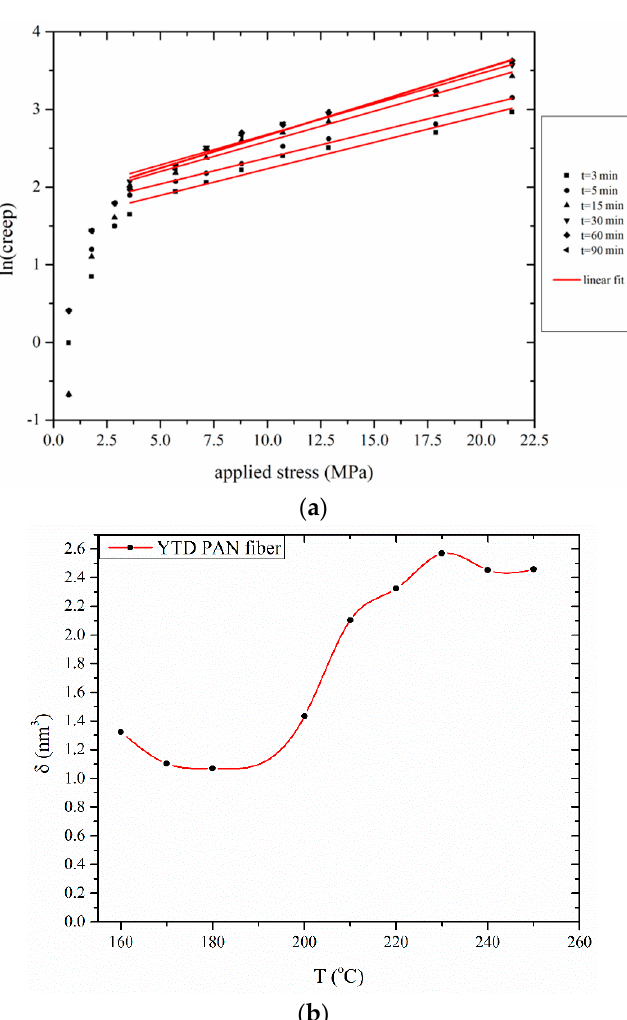
Figure 7. ( a ) Isochronous plot of creep logarithm vs stress during stabilization of YTD PAN fibers and ( b ) dependence of creep activation volume ( δ ) on stabilization temperature for Fibers A and B.